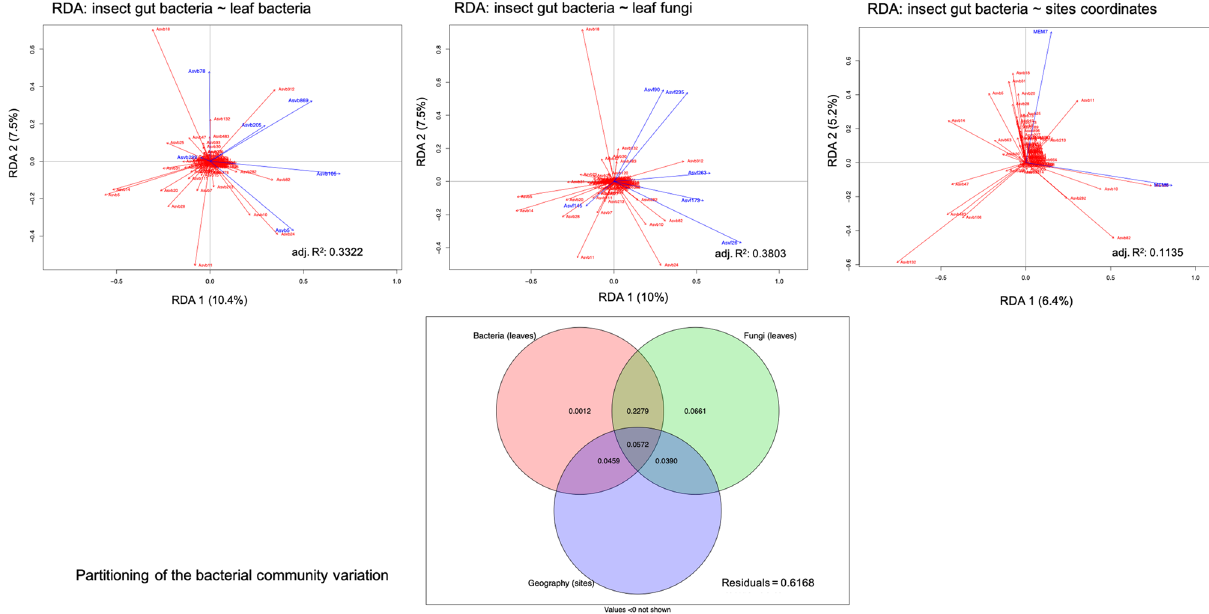
Figure 4. Variation partitioning of the gut bacterial community among three predictor matrices: bacteria associated with leaves (Hellinger-transformed), fungi associated with leaves (Hellinger-transformed), and dbMEM spatial eigenfunctions generated from the geographic coordinates of the sampling sites ( Fraxinus trees). The selected explanatory variables (leaves) are represented in blue, and the response variables (insects’ gut) in red. Thus, the three explanatory matrices (bacteria, fungi, and geographic coordinates) are represented in individual RDA analyses. The adjusted R-square (adj.R 2 ) corresponds to the R 2 adjusted to the model containing all variables. The figure below the RDAs represents the partitioning variation analyses of the bacterial community associated with adult EAB